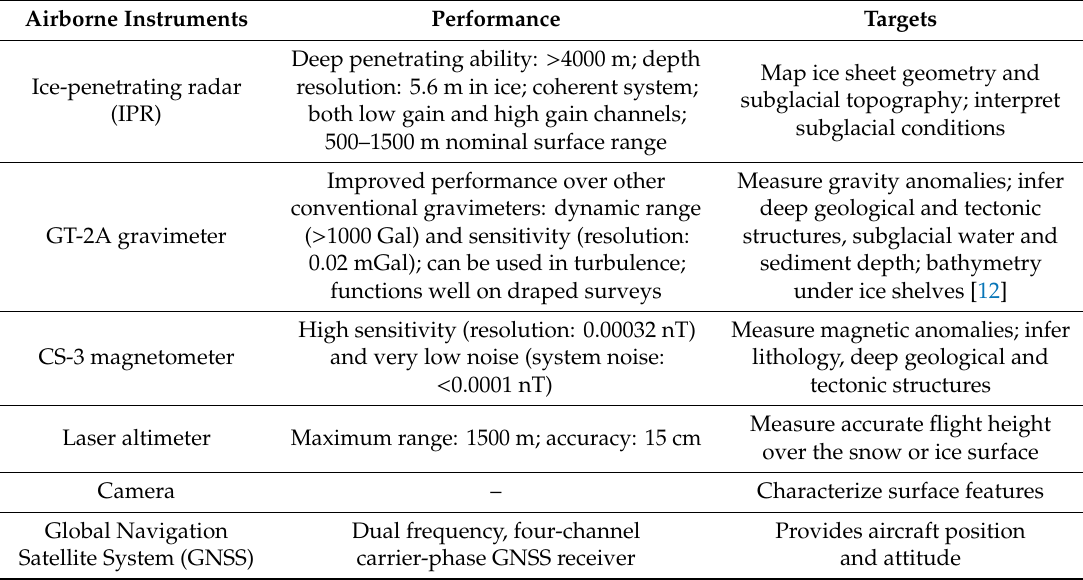
Table 1. The Snow Eagle 601 airborne instruments and their typical performance and observing targets. Airborne